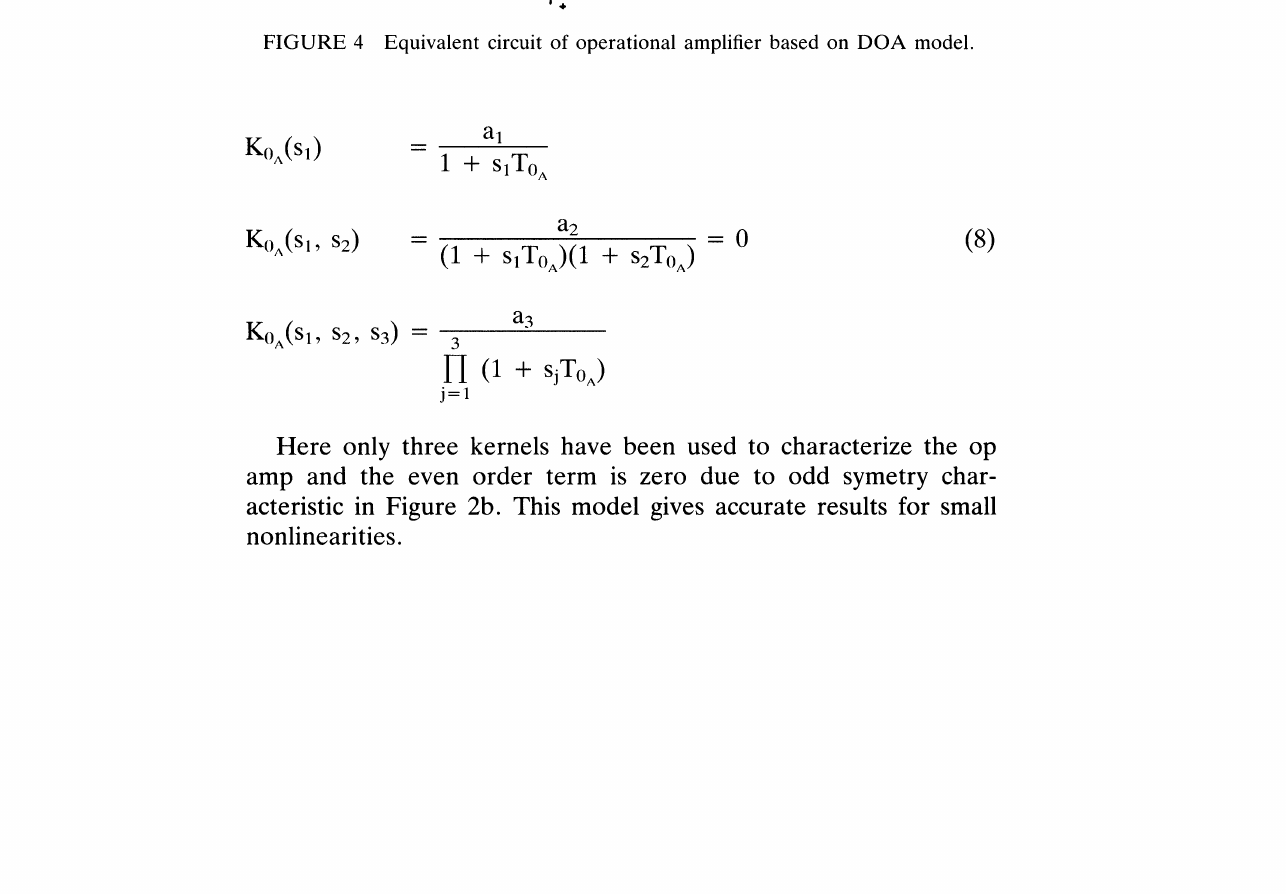
FIGURE 3(b) Signal flow-graph of above circuit.